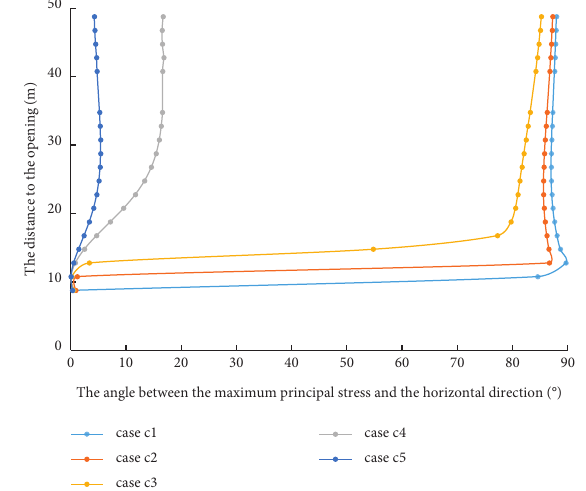
Figure 10: The relationship between the direction of the maximum principal stress and the distance to the